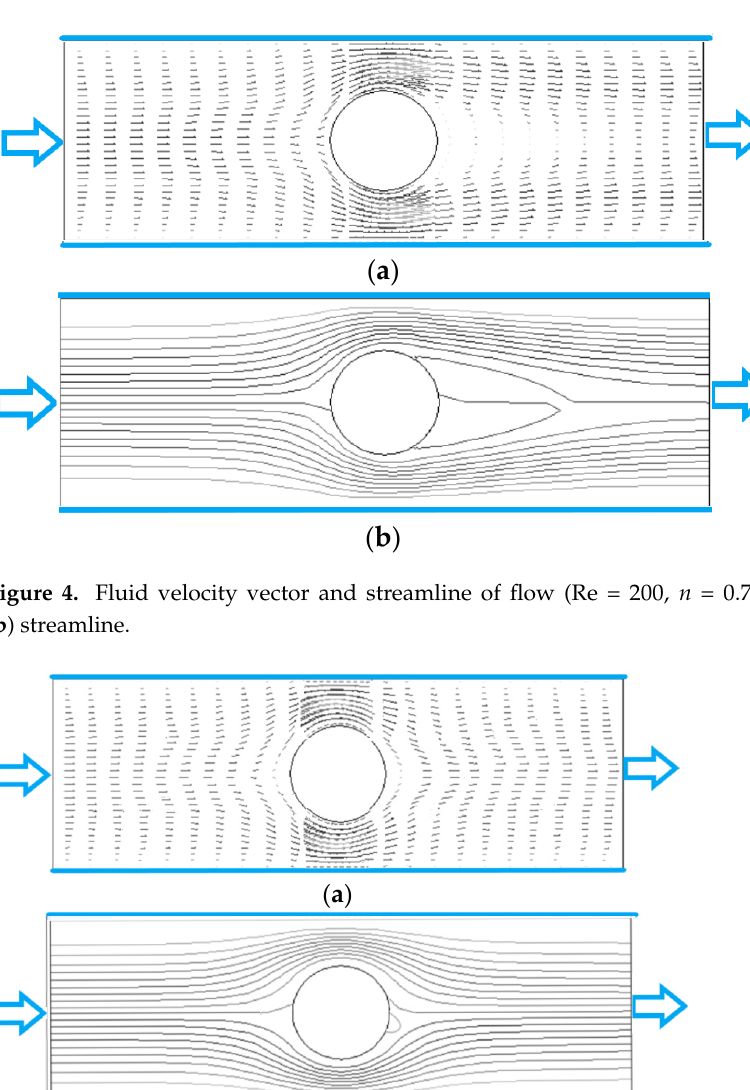
Figure 3. Fluid velocity vector and streamline of flow (Re = 2, n = 0.7). ( a ) velocity vector. ( b ) streamline.